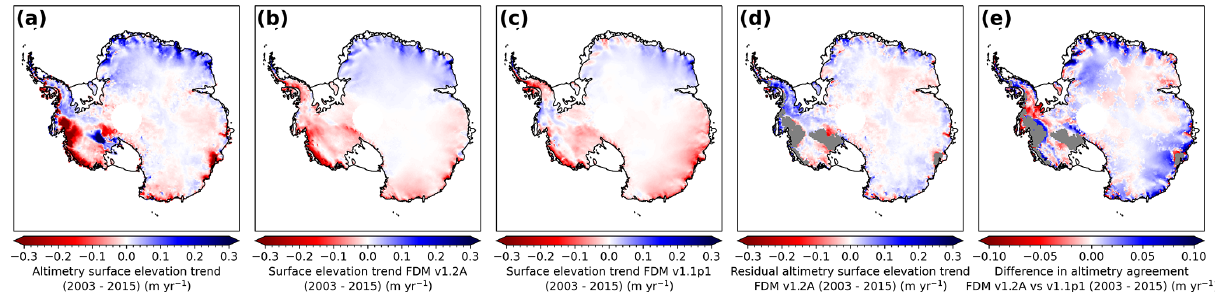
Figure 8. Maps of trends in surface elevation change over the period 2003–2015 from (a) multi-mission altimetry (Schröder et al., 2019a), (b) FDM v1.2A and (c) FDM v1.1p1 obtained using linear regression. (d) Residual trend of altimetry minus FDM v1.2A. (e) Difference in the altimetry agreement between FDM v1.2A and FDM v1.1p1 (absolute residual of FDM v1.1p1 compared to altimetry minus absolute residual of FDM v1.2A compared to altimetry). Regions within the ice-dynamical imbalance mask reported by Shepherd et al. (2019) are excluded in (d) and (e) and indicated by the grey-shaded area.